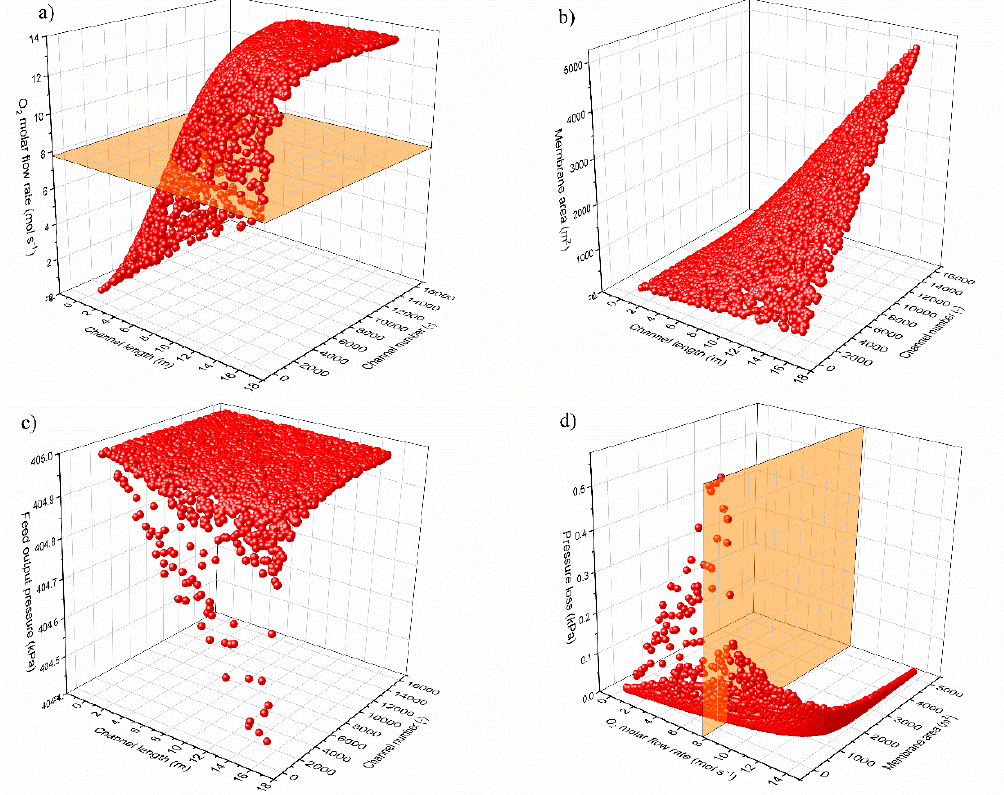
Figure 15. Results of the Monte Carlo simulation (3000 runs) to find the optimal membrane module design for the no-sweep case at 4 bar and SF = 40%. ( a ) oxygen molar flow rate across the membrane as a function of channel length and number of channels; ( b ) total membrane area as a function of channel length and number of channels; ( c ) feed output pressure as a function of channel length and number of channels; ( d ) representation of the optimal design point found at minimum pressure loss and minimum membrane area for a specific value of oxygen flow